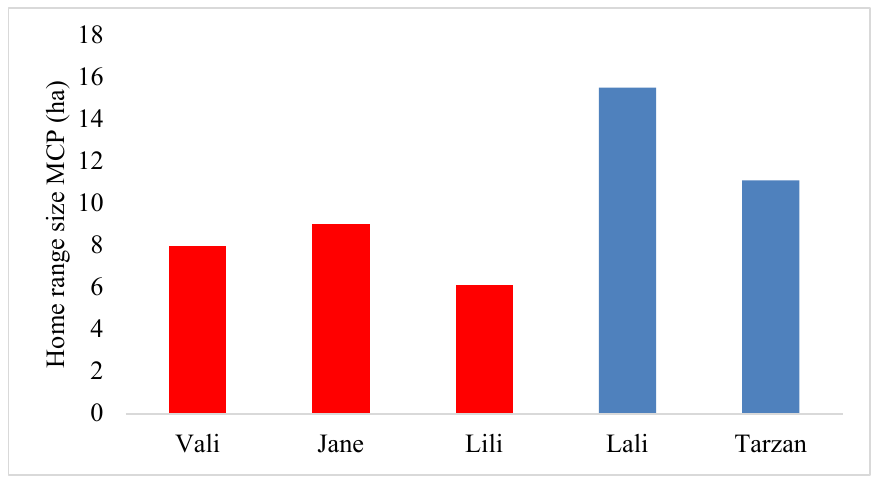
Figure 4. Individual home range sizes of Caspian whipsnakes ( Dolichophis caspius ) calculated using MCP during the activity period. (Red bars: females; blue bars: males).